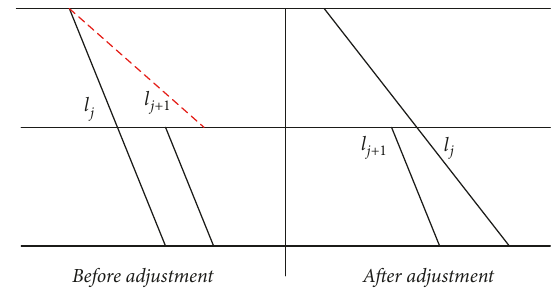
Figure 2: The condition of the strategy